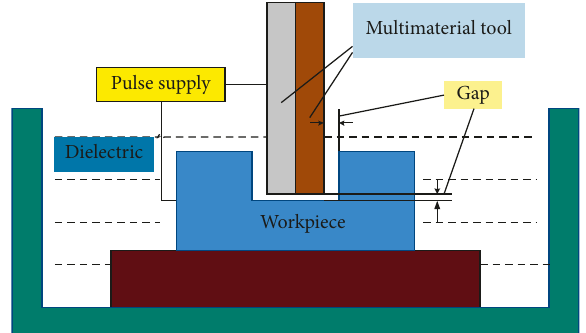
Figure 1: Multimaterial electrode EDM.